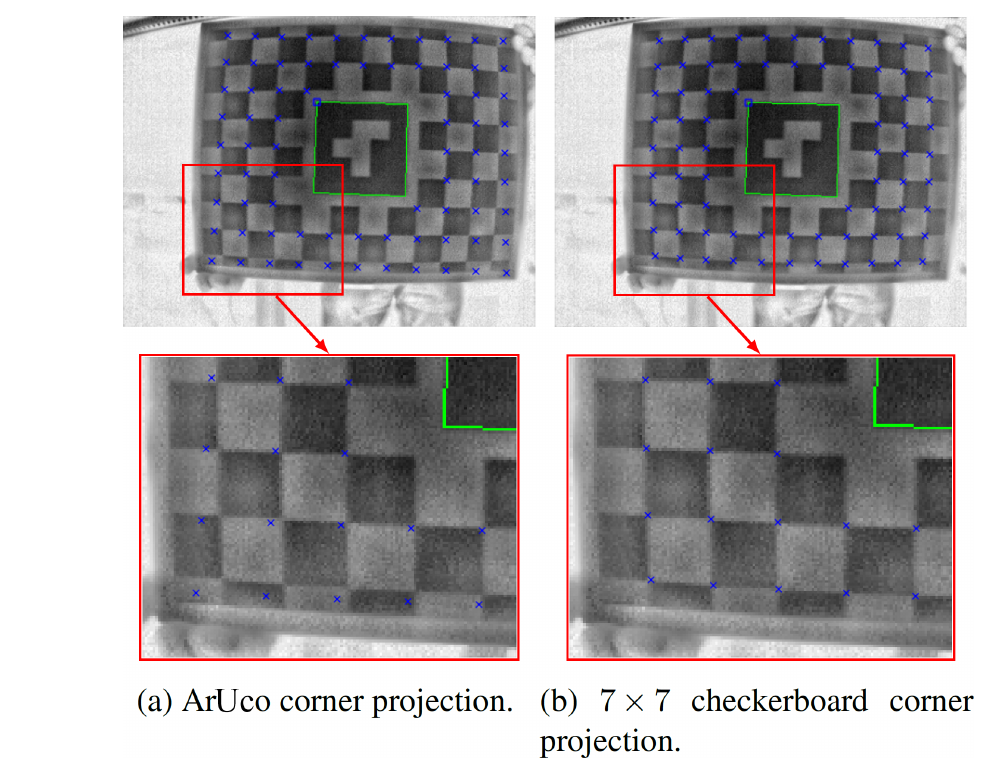
Figure 4. Increased projected corner precision after the initial calibration with an ArUco marker (a) and with the center 7 × 7 checkerboard corners (b)